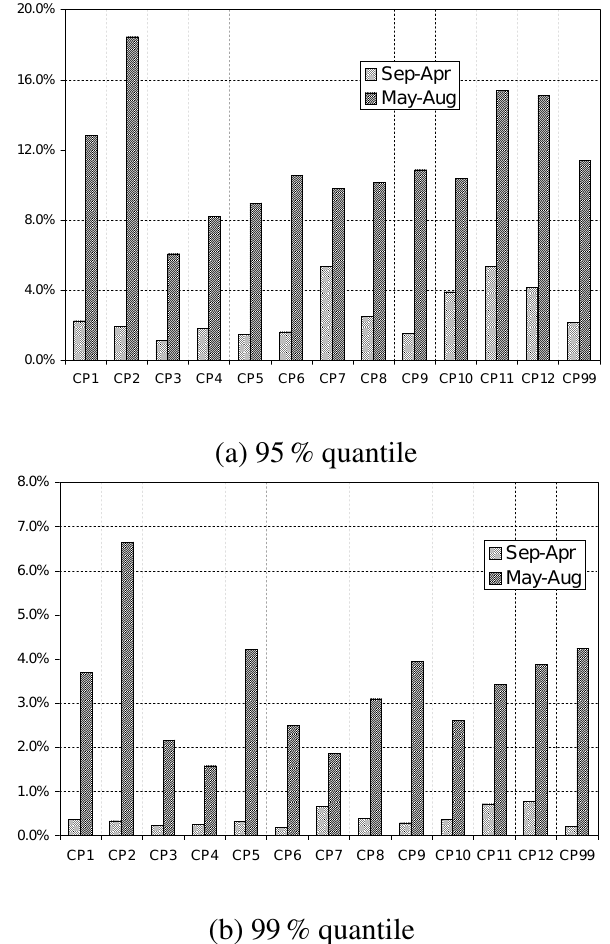
Fig. 4. Exceedance frequency of the 95% and 99% quantile for two seasons; quantiles and frequencies are calculated for all hours with R ≥ 0.1mm.